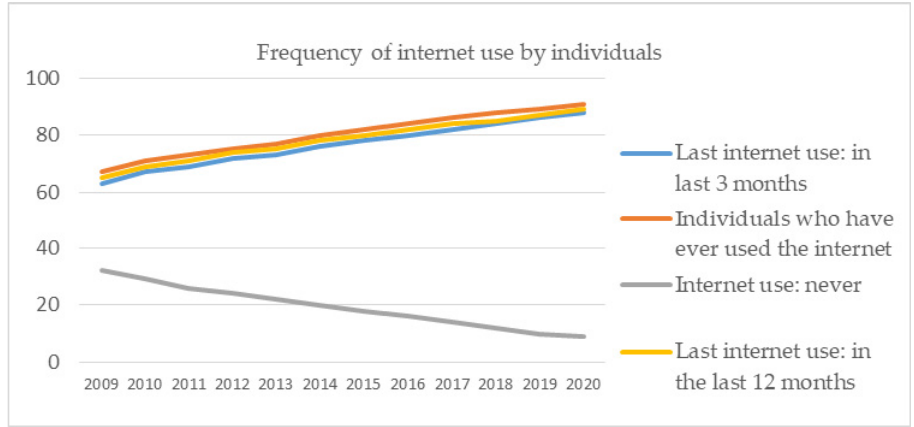
Figure 11. Frequency of internet use by individuals. Source: Authors projection using EUROSTAT database, Digital economy and society (t_isoc_i) Data extracted on 12 September 2021, online data code: TIN00028.